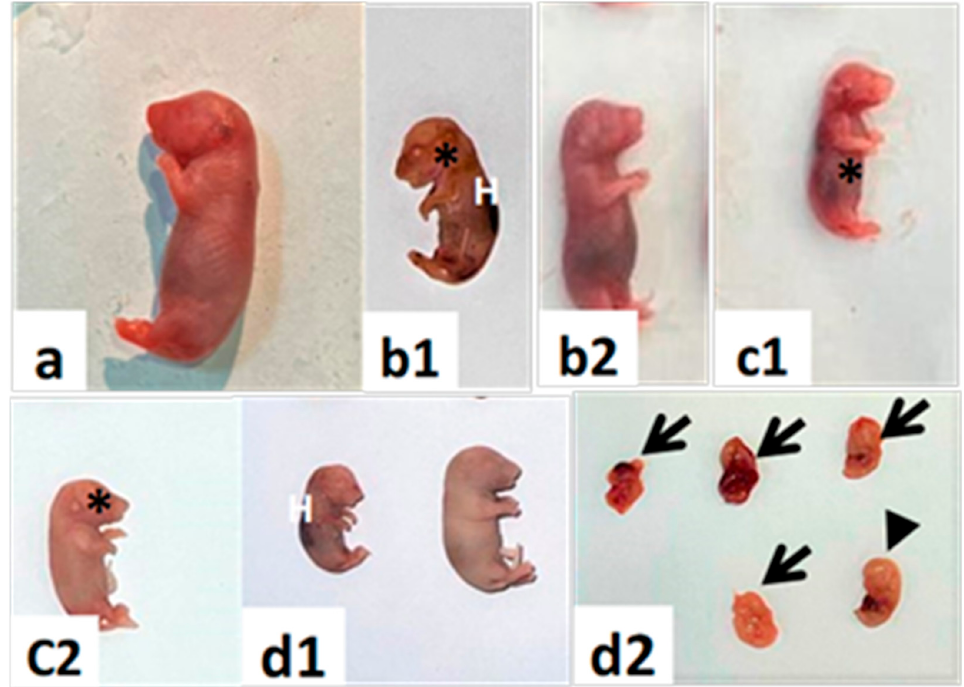
Figure 5. Photomacrographs of the whole mount of twentieth-day-old rat fetuses of pregnant rats treated with metronidazole at different gestation periods showing various morphological intrauterine growth restrictions (IUGR). ( a ) In the control group, the fetuses appeared healthy and normal. ( b1, b2 ) Group I, ( c1, c2 ) Group II, and ( d1, d2 ) Group III. Notice growth retardation (*), dead fetus (arrowhead), partially resorbed fetuses (arrows), and hematomas (H).